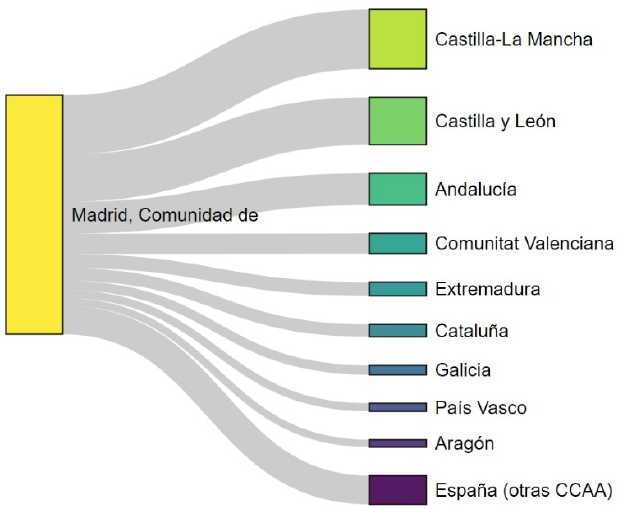
Figure 5. Mobility of Madrid residents on 24 November 2019 to other autonomous communities. Compiled by the authors using data from the INE [45] corresponding to the experimental study, “Mobility studies using mobile telephones”. The figure shows the number of Madrid residents who travelled to each autonomous community with respect to the total number of travellers from Madrid that day. From highest to lowest percentage: Castilla-La Mancha (24.9%), Castilla y León (19.9%), Andalucía (13.3%), Comunitat Valenciana (8.4%), Extremadura (5.8%), Cataluña (5.2%), Galicia (4.0%), País Vasco (3.4%), Aragón (3.1%), Islas Canarias (2.7%), Murcia (1.9%), Cantabria (1.7%), Navarra (1.2%), Islas Baleares (1.2%), La Rioja (1.1%), Melilla (0.1%) and Ceuta (0.1%).